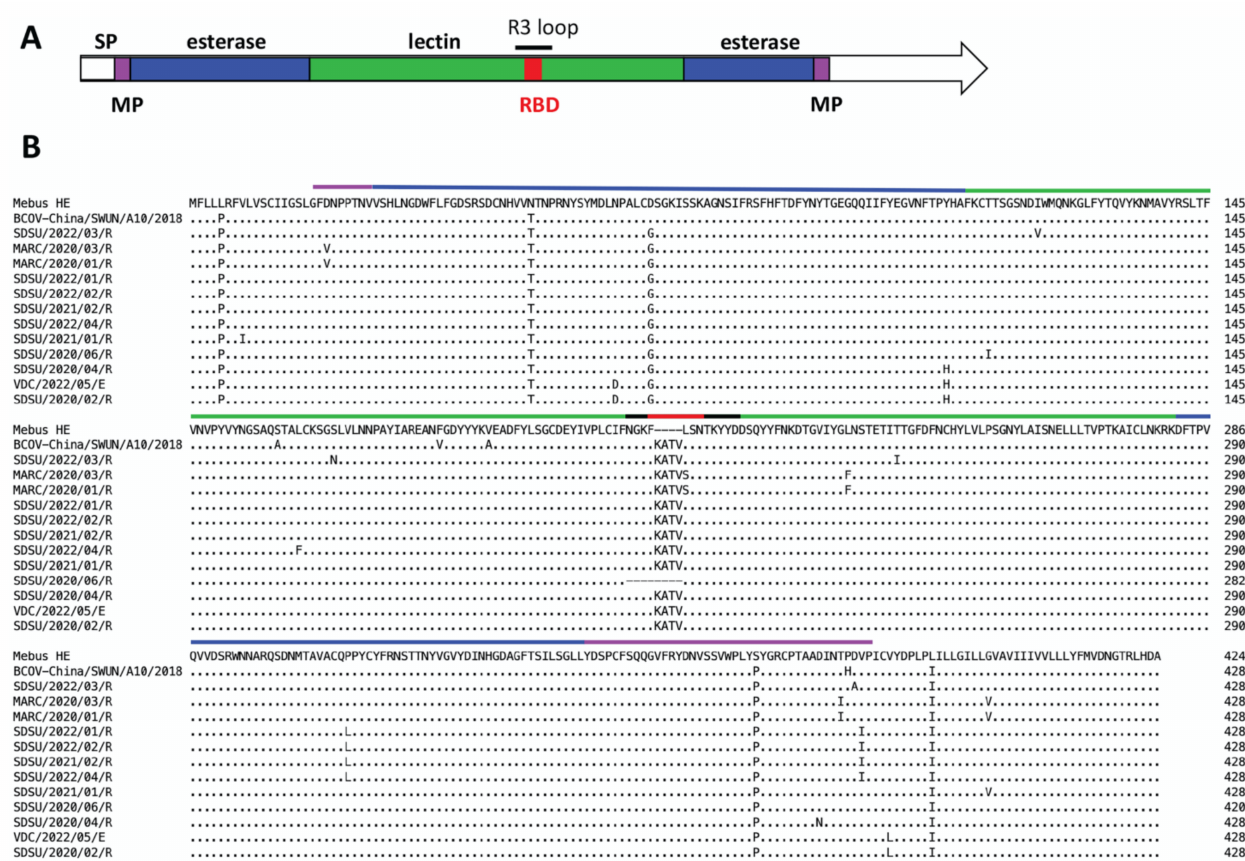
Figure 1. Alignment of variant HE proteins with HE from the reference BCoV Mebus genome. Panel A. HE protein map with domains annotated according to [28] with the signal peptide (SP) colored white, the lectin domain colored green, the esterase domain colored blue, and the membrane-proximal (MP) domain colored pink. The R3 loop and the receptor binding domain (RBD) are also annotated. Panel B. Alignment of 12 HE variant proteins from this study with the HE-insertion variant from China (GenBank accession no. MN982199, isolate BCoV-China/SWUN/A10/2018) and the reference Mebus sequence. Amino acids divergent from the reference Mebus sequence are shown while homologous amino acids are represented as a